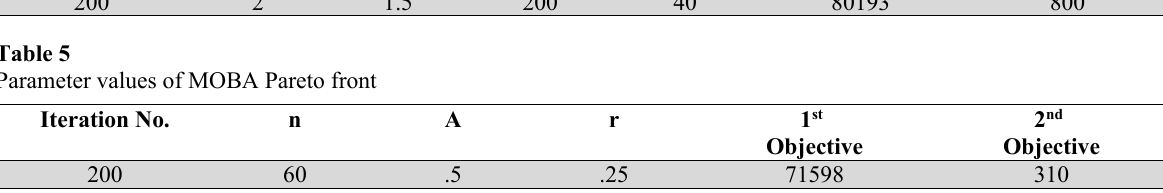
Parameter values of MOPSO Pareto front Iteration No.